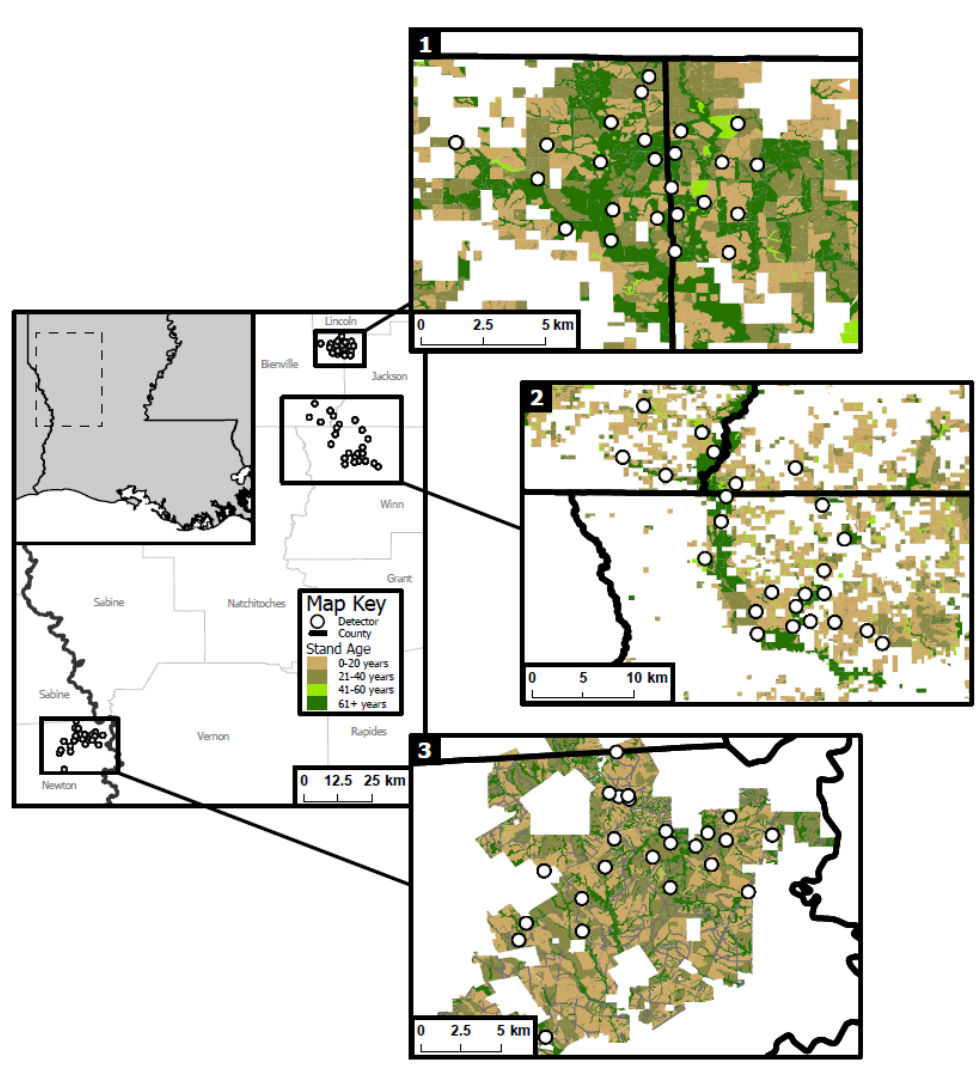
Figure 1. Twenty-four detector locations were placed in each of three main study sites: ( 1 ) Jackson- Bienville, LA, ( 2 ) Winn, LA, and ( 3 ) Newton, TX during the winters of 2018 and 2019.